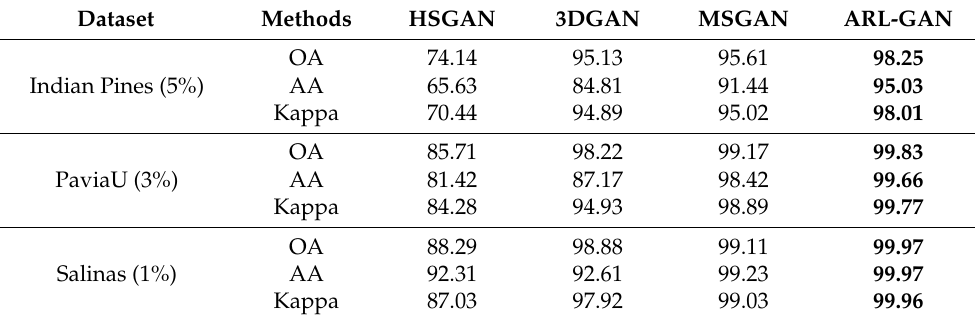
Table 8. Classification results of 3DGAN, HSGAN, MSGAN, and ARL-GAN.